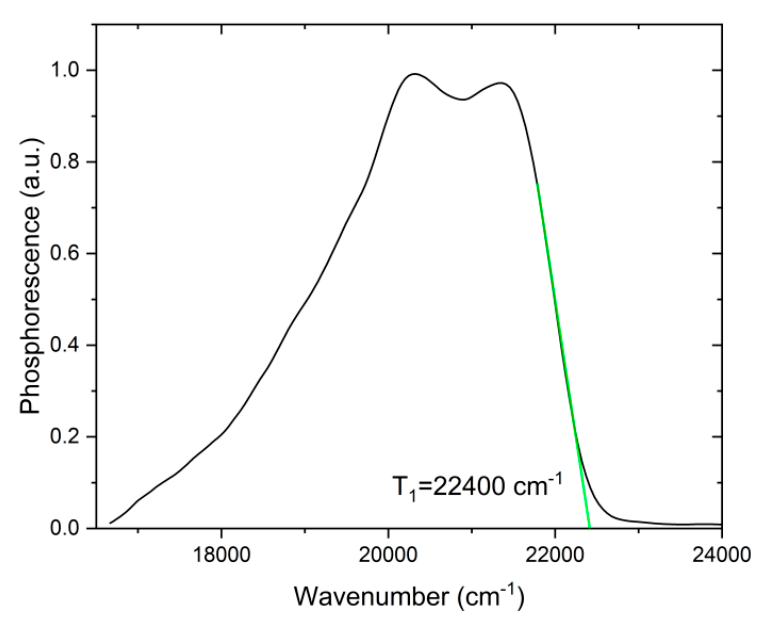
Figure 6. Low-temperature (77 K) phosphorescent spectrum of complex 2 in solid form. The T 1 energy level value of 22,400 cm − 1 is favorable for sensibilization of Eu 3+ and Sm 3+ ions, because the energy gaps between resonant levels of these ions and T 1 level of